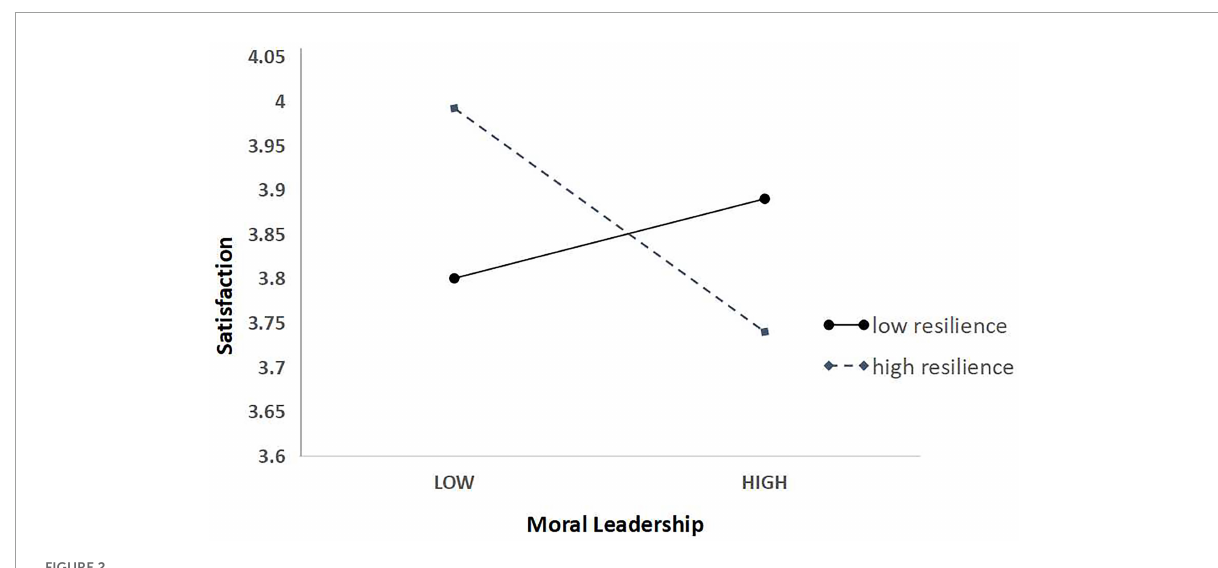
FIGURE2 Moderating effect